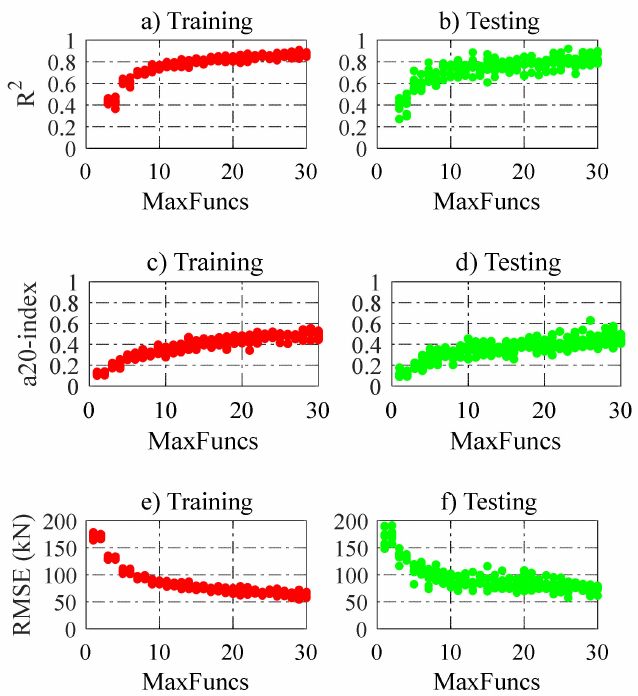
Figure 4. The performance of 210 MARSs models.